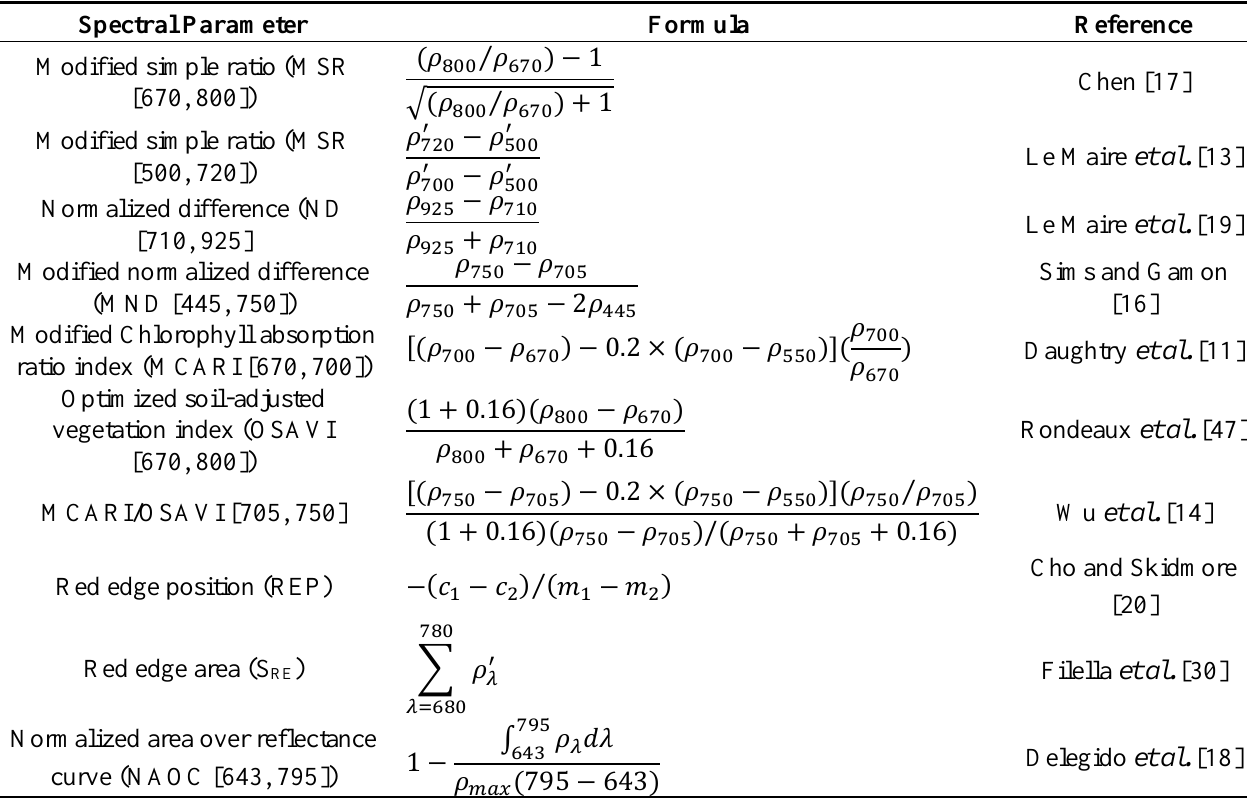
Table 1. Some classical chlorophyll-related spectral parameters.